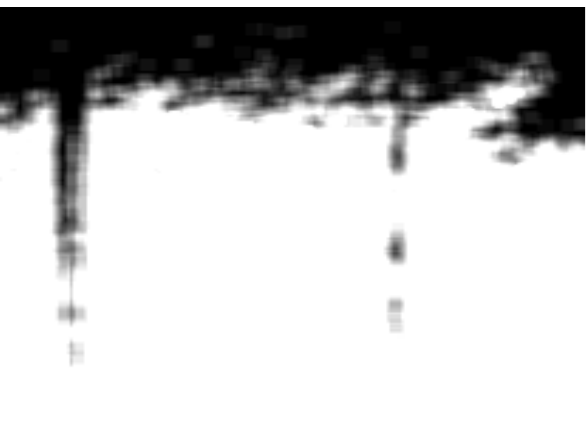
Figure 5. The image before pooling.